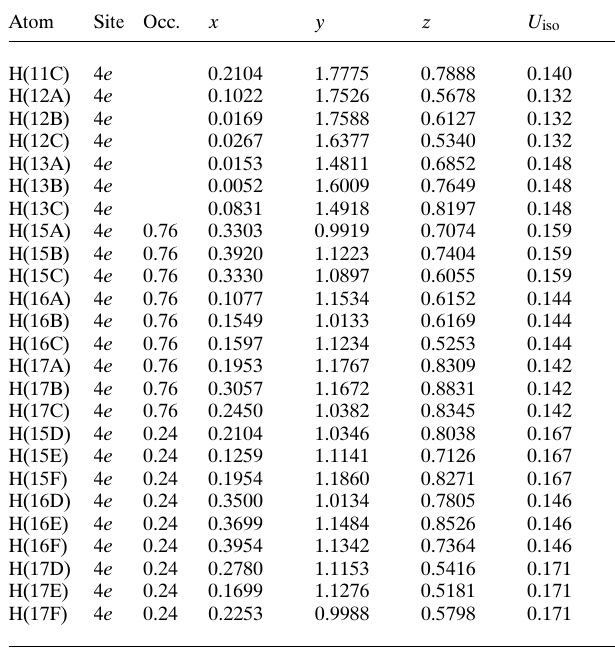
Table 1. Data collection and